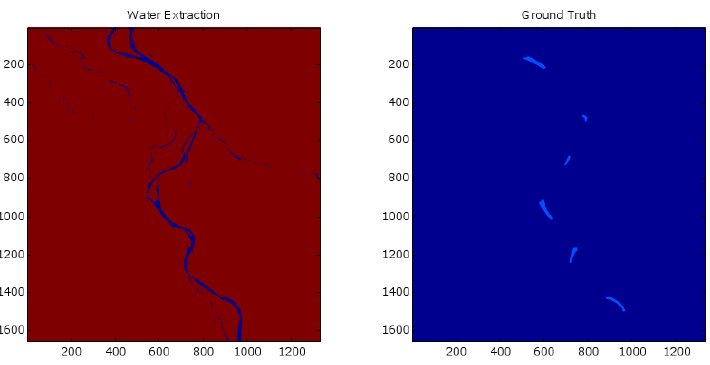
Figure 5. ( Left ): River (blue) has been extracted using 99% threshold under QDA. ( Right ): Light blue polygons denote location of water ground-truth from original image